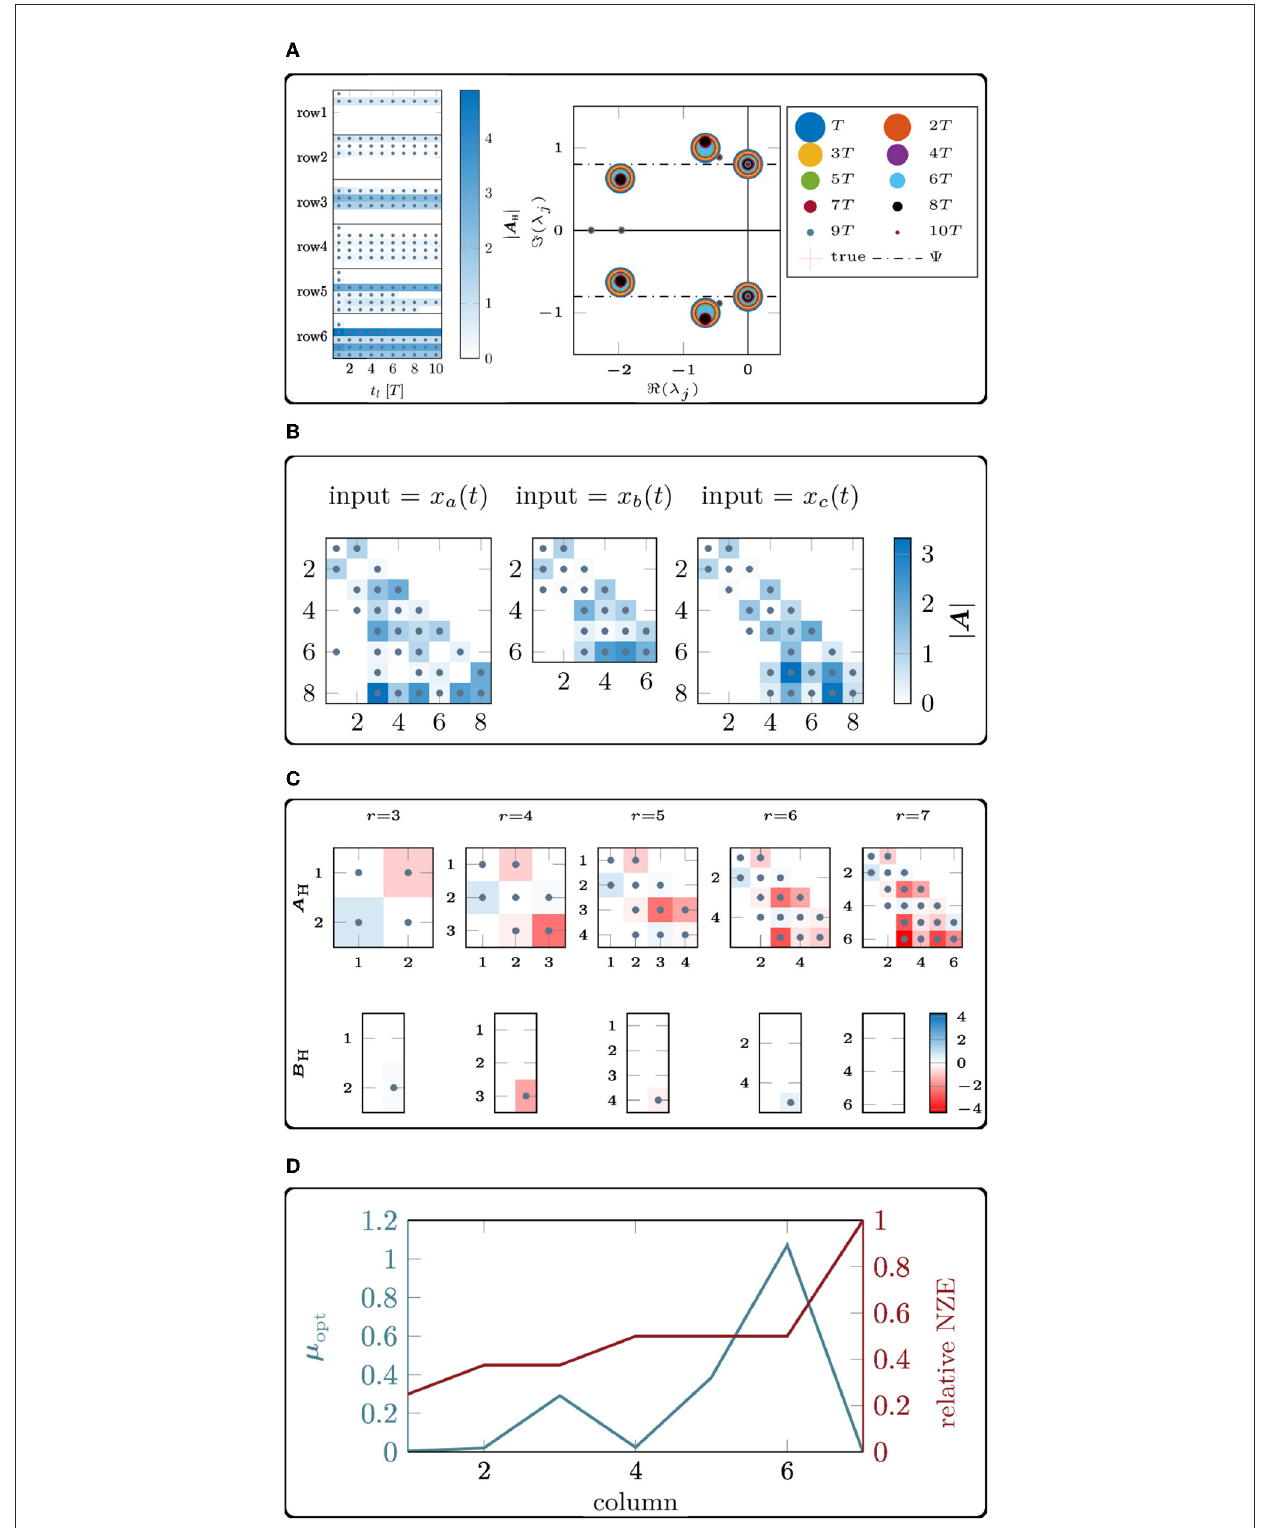
FIGURE6 (A) HAVOK model results for variations of the algorithm parameters, studied by computing the model for a range of values. The state matrix A H and HAVOK model eigenvalues for different input time spans t l ∈ [ T : 10 T ]. In the figure, one column represents one matrix A H , with the rows stacked on top of each other. This view allows for a direct comparison of the matrix entries. (B) HAVOK model results for variations of the algorithm parameters, studied by computing the model for a range of values. The state matrix A H obtained when using different input time series x a ( t ), x b ( t ) or x c ( t ) from